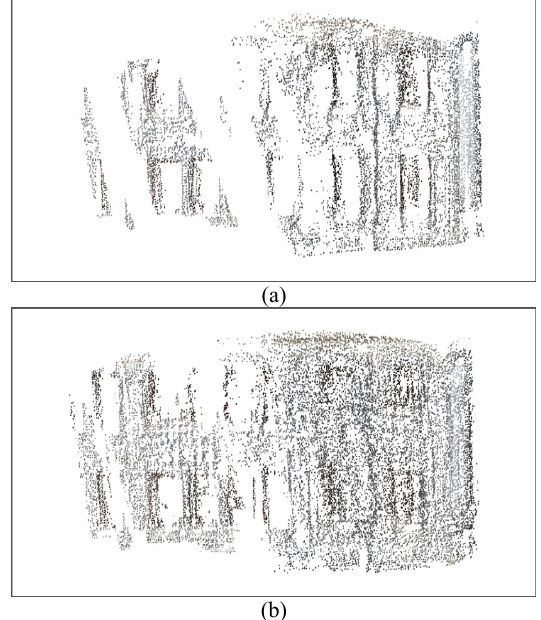
Figure 10 . The point clouds generated by initial patch optimization: (a) the traditional method proposed by Locher (Locher, 2016); (b) the proposed method proposed in this work.